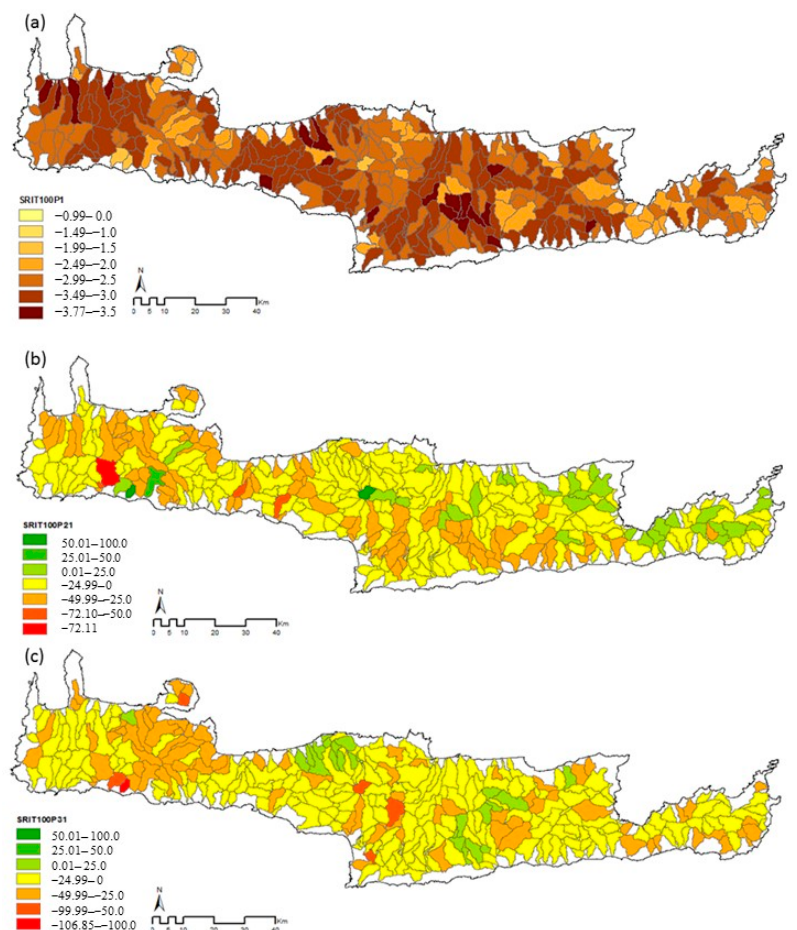
Figure 4. Hydrological drought frequency analysis under climate change using GEV distribution for T = 100 years and for study periods ( a ) 1985–2010 (baseline period), ( b ) 2025–2050 (relative percentage change from the baseline), ( c ) 2075–2100 (relative percentage change from the baseline).